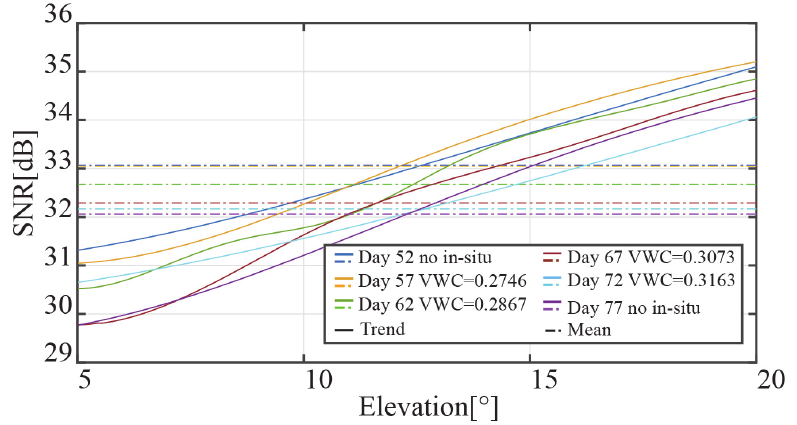
Figure 11. The Comparison between GPS PRN2 SNR trend